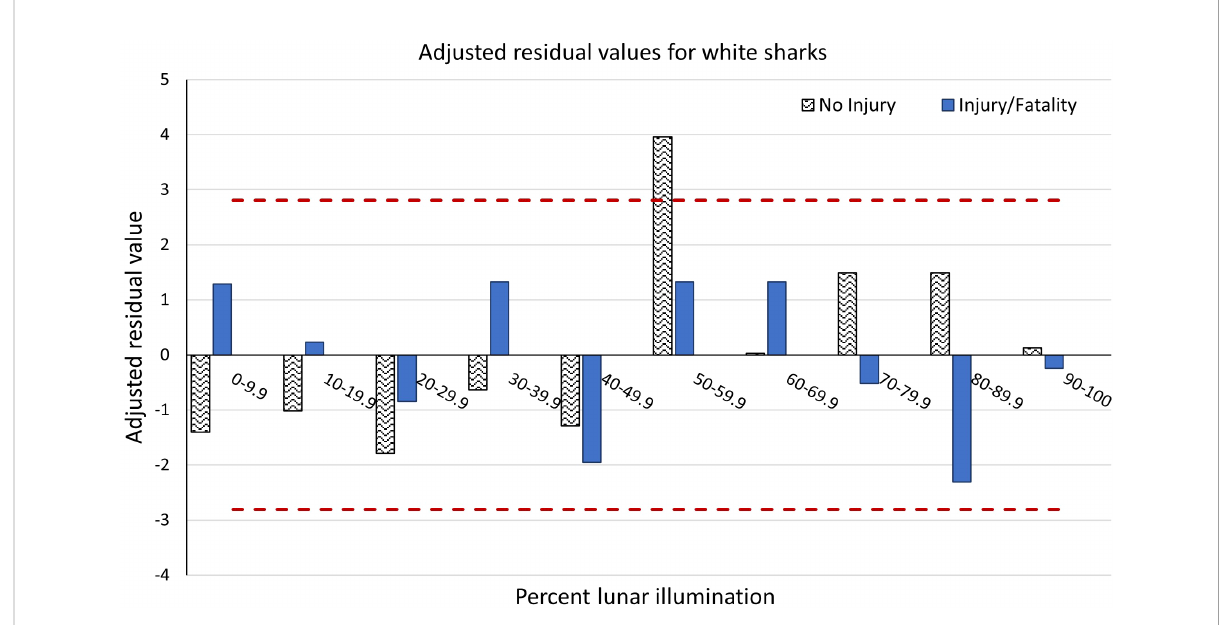
FIGURE 10 Adjusted residual values showing the direction and magnitude of difference between expected and documented number of White Shark incidents by lunar illumination deciles, split by no injury and injury/fatality. The horizontal dashed red lines represent the cutoff for 95% signi fi cance. Bars that do not extend past the red horizontal dashed lines represent values that did not statistically differ from the expected count when analyzed with a Chi-squared test. Injury categories were tested separately but are presented